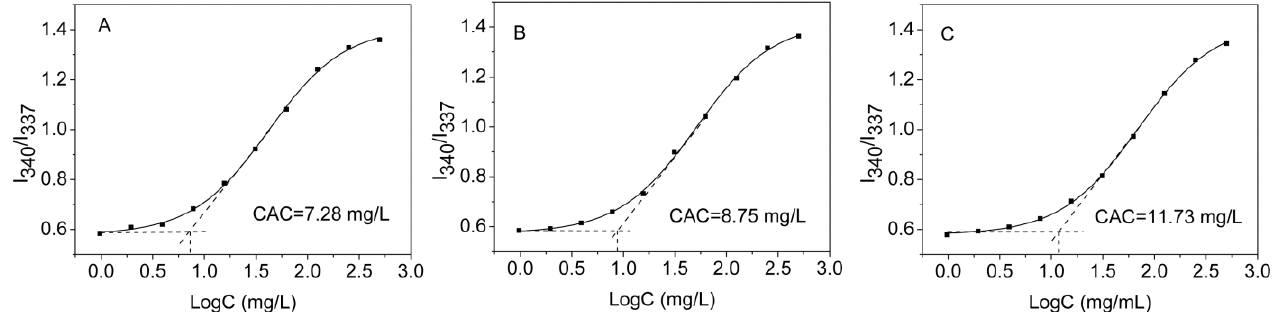
Figure 4. Plot of the fluorescence intensity ratio I 340 /I 337 in the excitation spectra versus the logarithm of the polymer concentration: ( A ) m PEG-HTO- m PEG-1, ( B ) m PEG-HTO- m PEG-2, and ( C ) m PEG- HTO- m PEG-3.